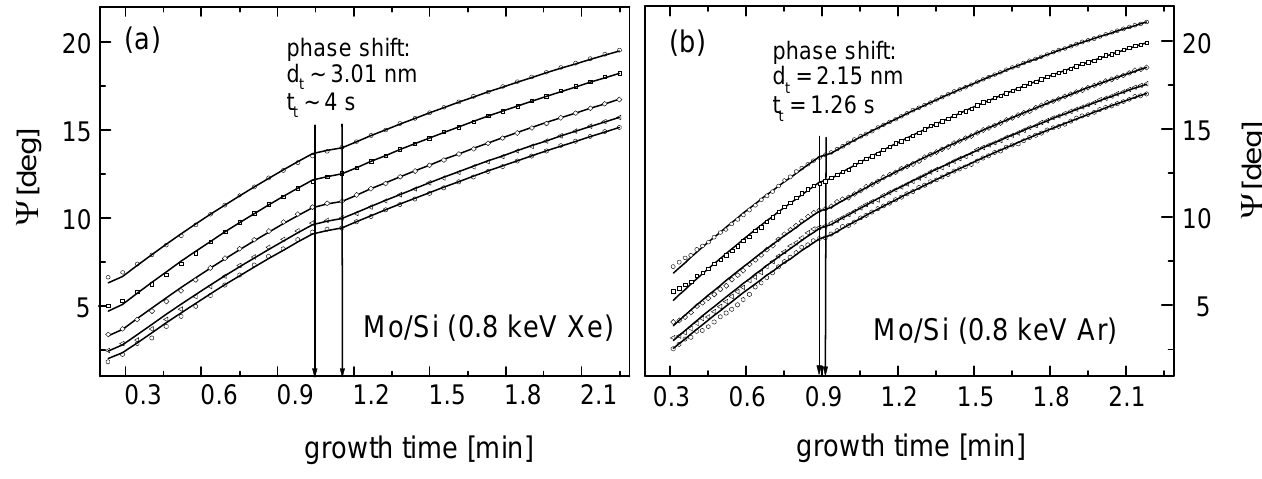
Figure 17 . Real time spectroscopic in situ ellipsometry experimental (points) and model (solid lines) spectra of Mo layer growth in the (a) Xe sputter regime (E f = 1.6 sccm) and (b) Ar sputter regime (E Xe lines refer to different wavelengths [134].